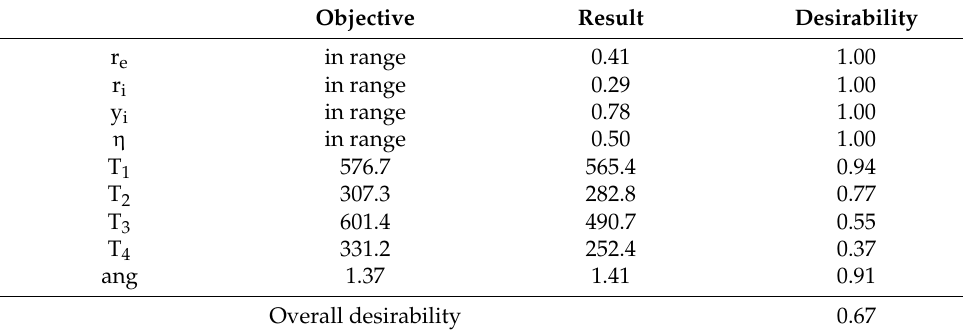
Table 7. Optimization objectives, results, and desirability.